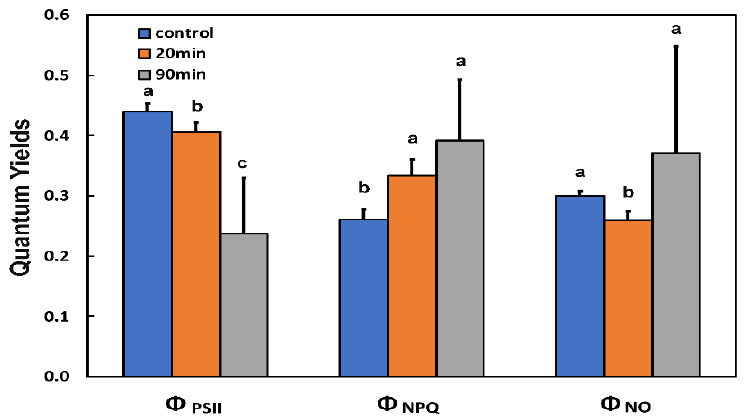
Figure 1. Changes in the allocation of absorbed light energy at photosystem II ( Φ PS ΙΙ , Φ NPQ and Φ NO ) of potato leaves at the whole leaf level, before (control), and after 20 and 90 min feeding by the sap-sucking insect Halyomorpha halys . Error bars ± SD ( n = 5). In each parameter, the columns with different lowercase letters are statistically different ( p < 0.05).